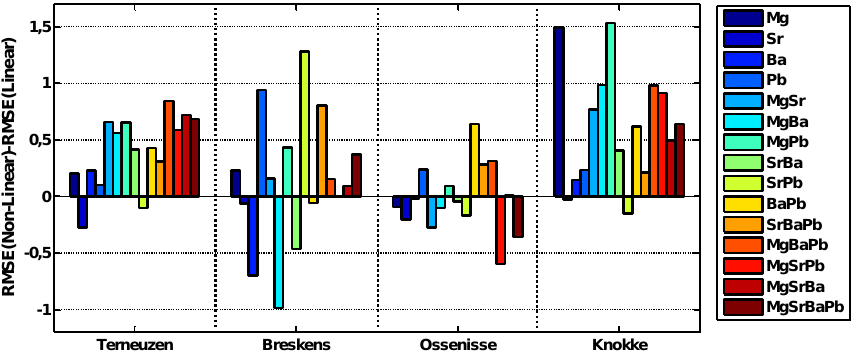
Fig. 5. Differences of model reconstruction performance obtained using the validation data between linear and non-linear multi-proxy models, for the 4 study sites. Positive differences indicate that the non-linear model performs better. The 15 different colors represent de 15 studied proxy